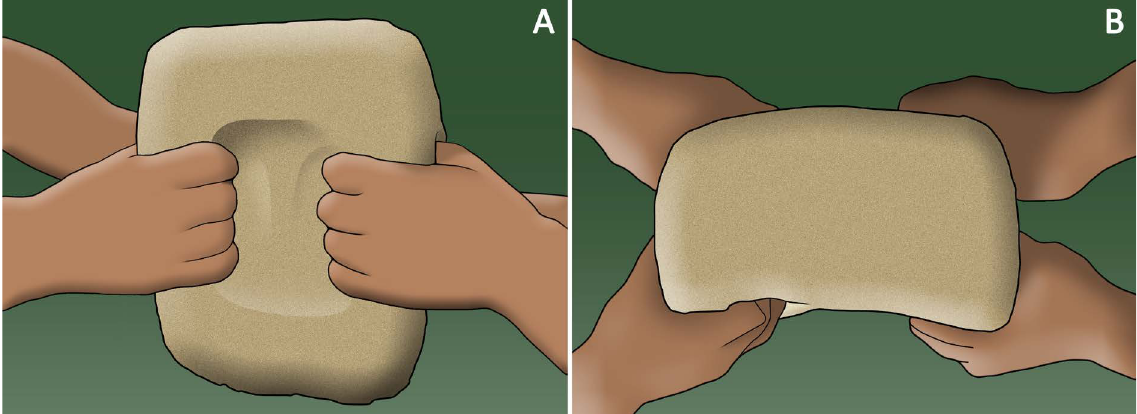
Figure 6. Reconstruction of the use of tool ID 9120, handled by two people at the same time: side view (A) and top view (B). (Graphic reconstruction by F.